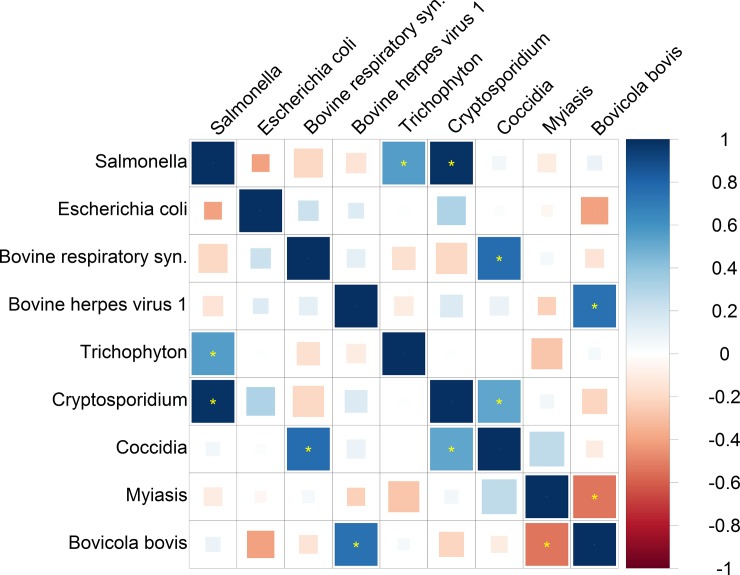
Genetic correlations among the 9 calf resistance traits analyzed by G-REML.Blue, positive genetic correlation; red, negative genetic correlation. Larger squares correspond to more significant P values. Genetic correlations that are different from zero at a false discovery rate (FDR) of 1% are shown as full-sized squares. Genetic correlations that are significantly different from zero after Bonferroni correction for the 36 tests in this analysis are marked with a yellow asterisk. We show results that do not pass multiple-testing correction as smaller squares. All genetic correlations in this report can be found in tabular form in S1 Table.